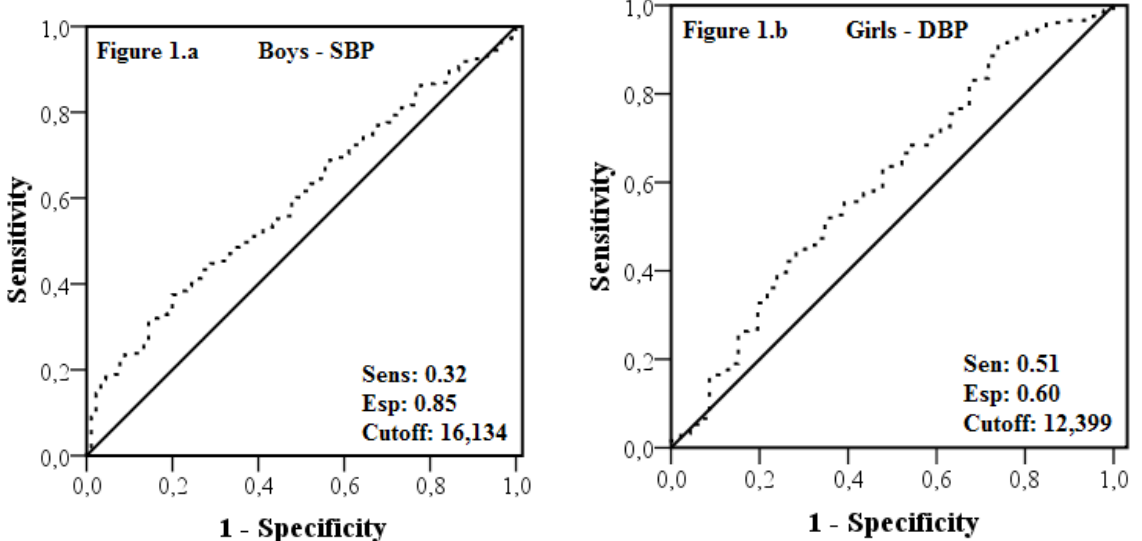
Figure 1. Area under ROC curve between the number of steps/day and the increased systolic blood pressure in boys (figure 1.a) and increased diastolic blood pressure in girls (figure 1.b).